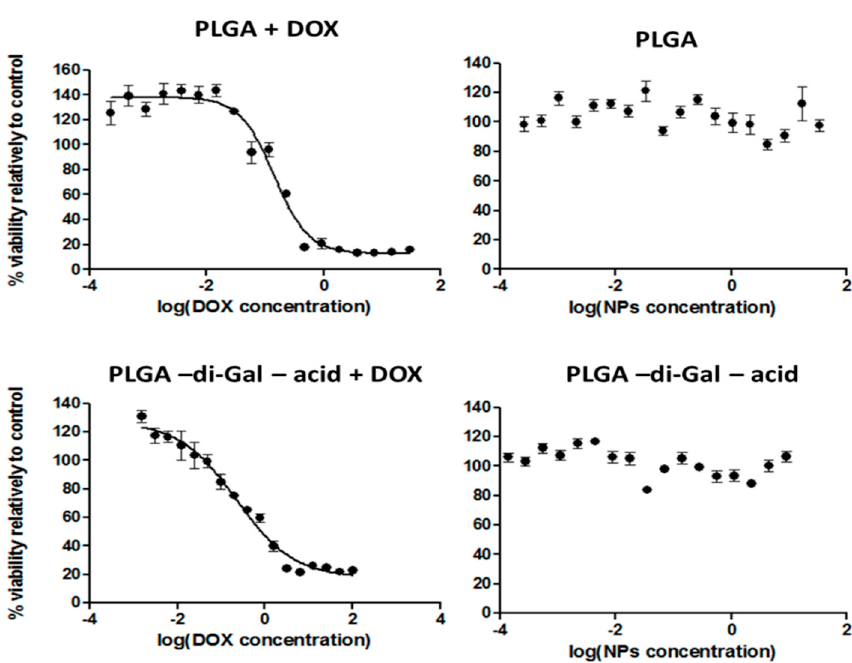
Figure 8. Dose-response curves of doxorubicin-loaded NPs and empty NPs exposed to HepG2 cells for 48h: PLGA NP (30 μ g/mL to 0.38 ng/mL); PLGA-di-GAL- acid NP (150 μ g/mL to 1.1 ng/mL).